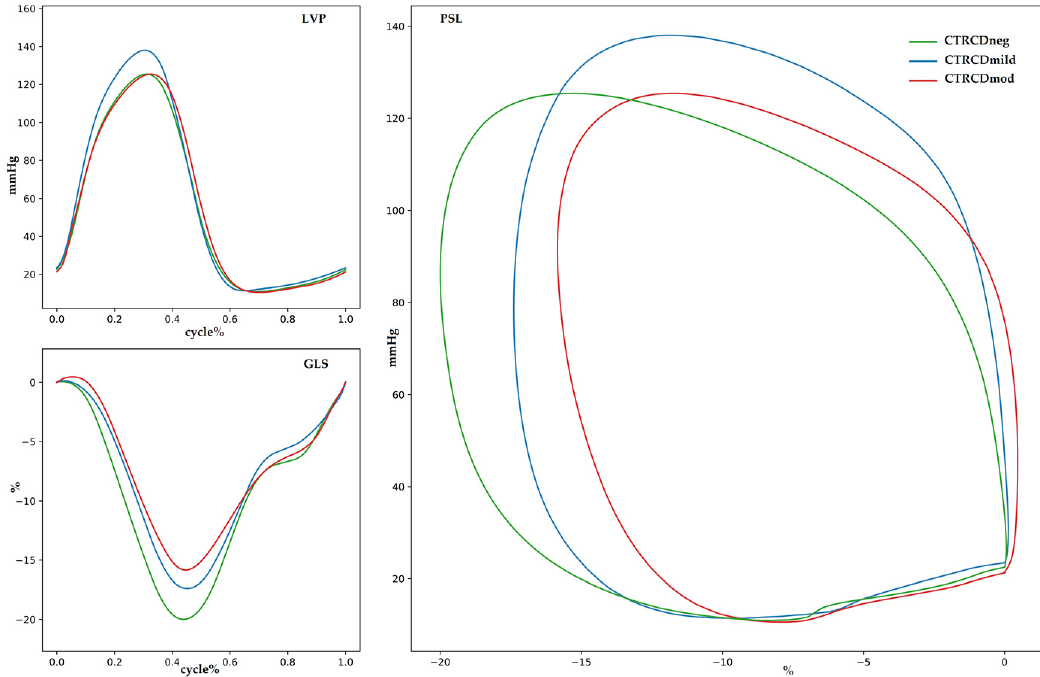
Figure 2. PSL analysis for CTRCD neg (green), CTRCD mild (blue) and CTRCD mod (red) at 12 M fol- low-up.